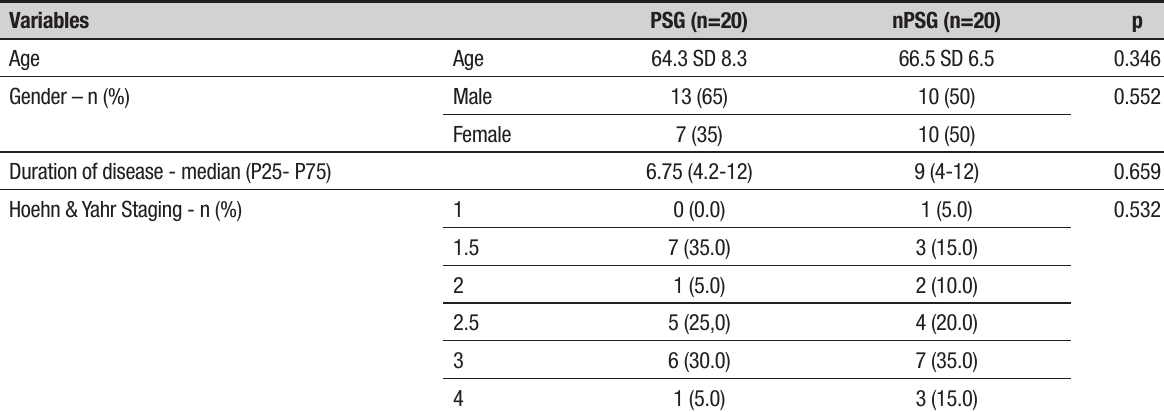
Table 1. Sample characteristics.